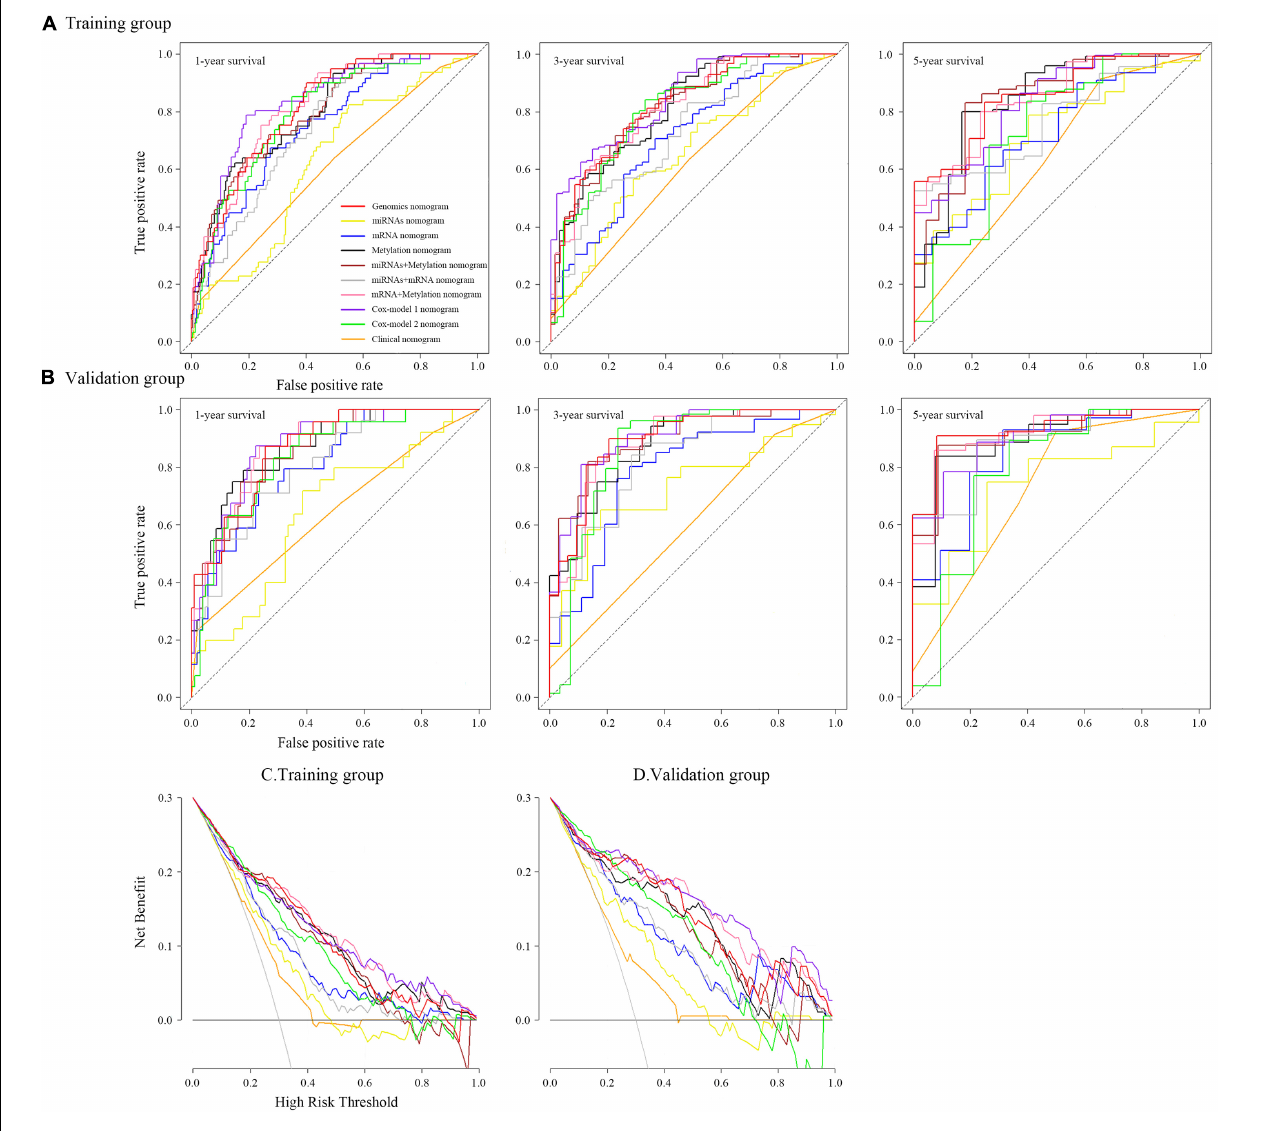
FIGURE 6 | Time-dependent receiver operating characteristic curves on 1, 3, and 5 years of each nomogram and decision curve analysis for each